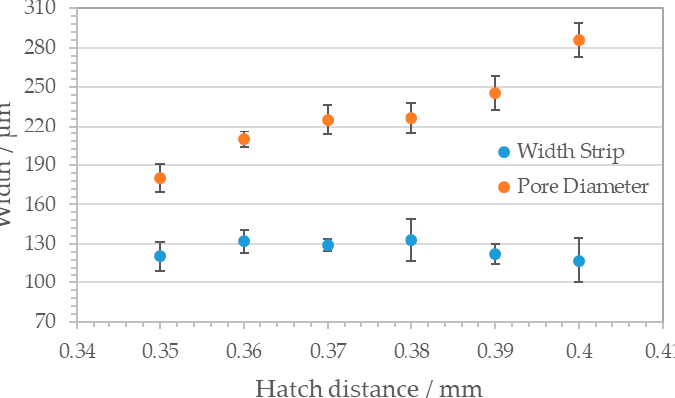
Figure 8. Correlation between hatch distance and pore geometry of the honeycomb pattern. Blue dots: width strip, red dots: pore diameter. With rising hatch distance, the pore diameters increase while the width strip remains constant.